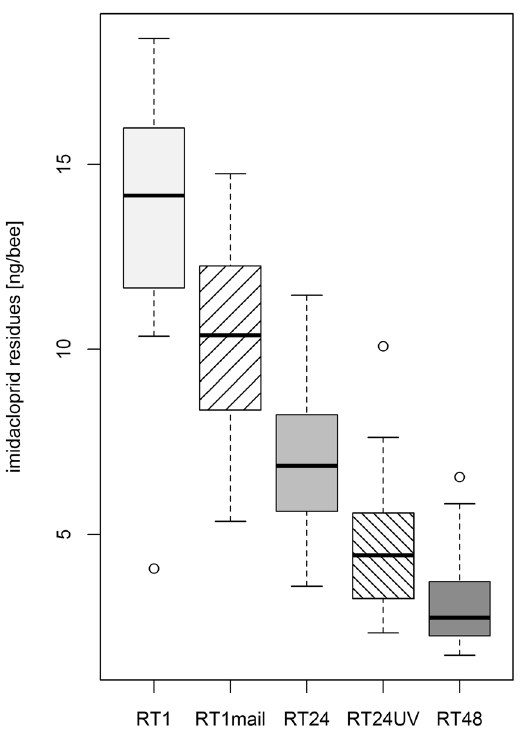
Figure 2. UV light accelerated the decrease of whole-body imidacloprid residues in honeybees, transportation on ice had no significant effect. Individual honeybees were fed with a dosage of 41 ng/bee. The honeybees were frozen after one hour (RT1, RT1mail), 24 hours (RT24, RT24UV), or 48 hours at room temperature. The samples of RT1, RT24, RT24UV, and RT48 were sent on dry ice with express delivery, RT1mail samples were sent without cooling via standard parcel service to the analytical laboratory (n = 150 bees/group). The mode of transport did not significantly affect imidacloprid residue levels (Comparison RT1 vs. RT1mail: p = 0.093). Intensive UV-light (RT24UV) significantly accelerated the decrease of imidacloprid (comparison RT24 vs. RT24UV: p = 0.0163; RT48 vs. RT24UV: p = 0.1637, see statistical report in